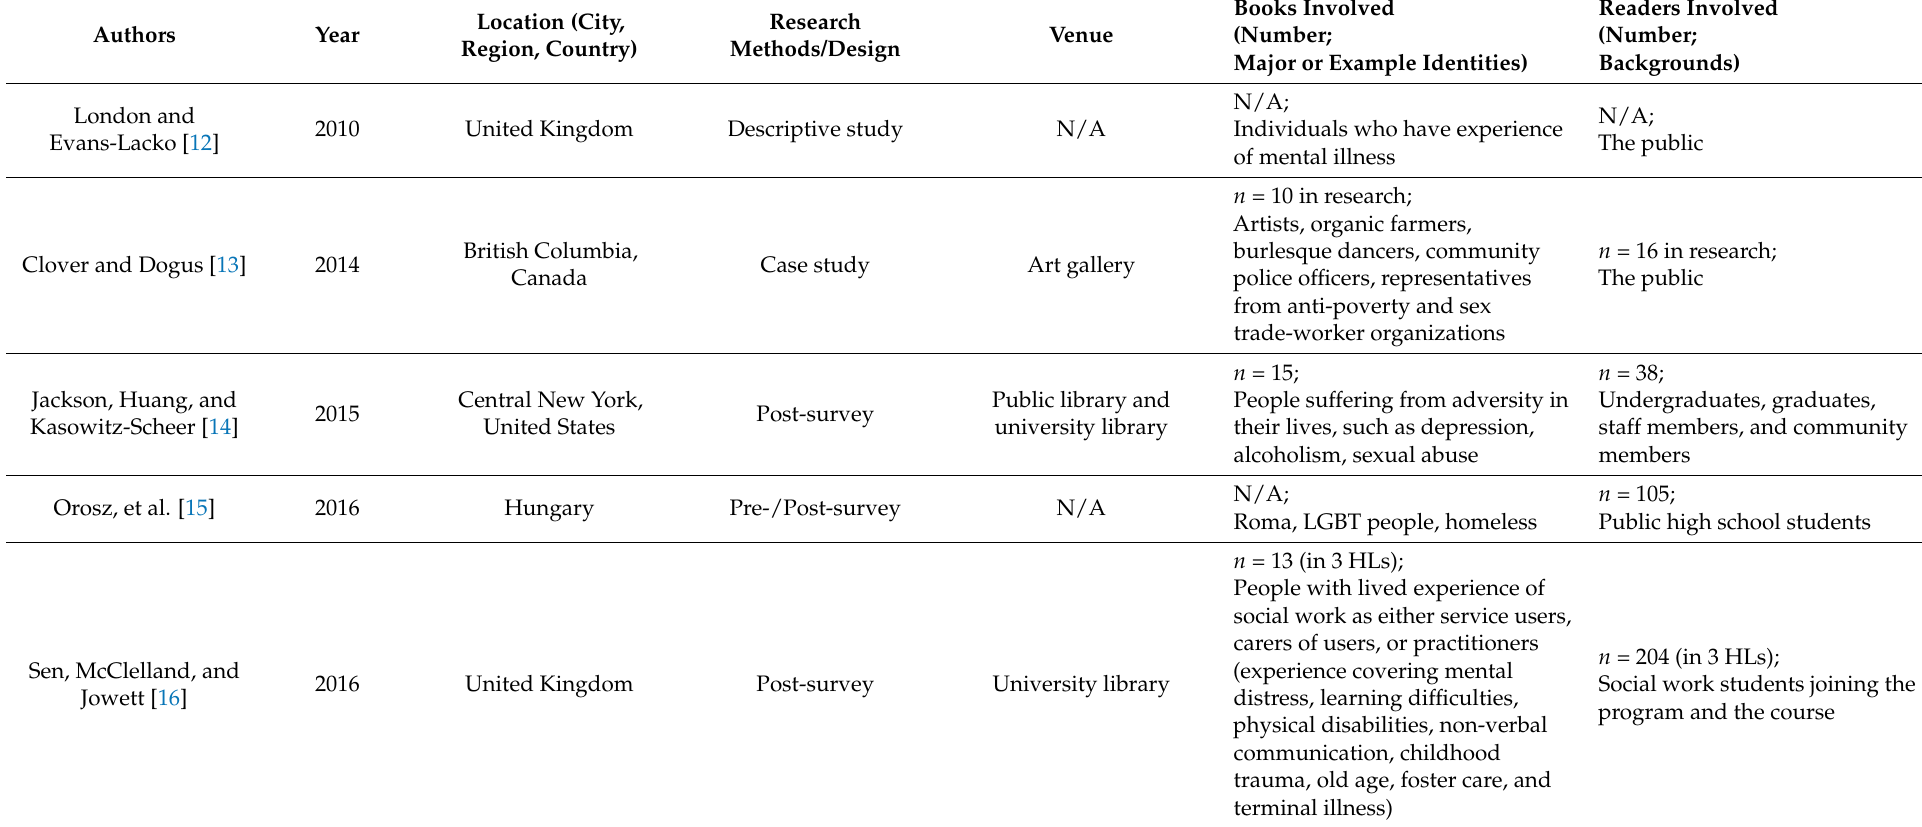
Table 1. Summary of characteristics of included